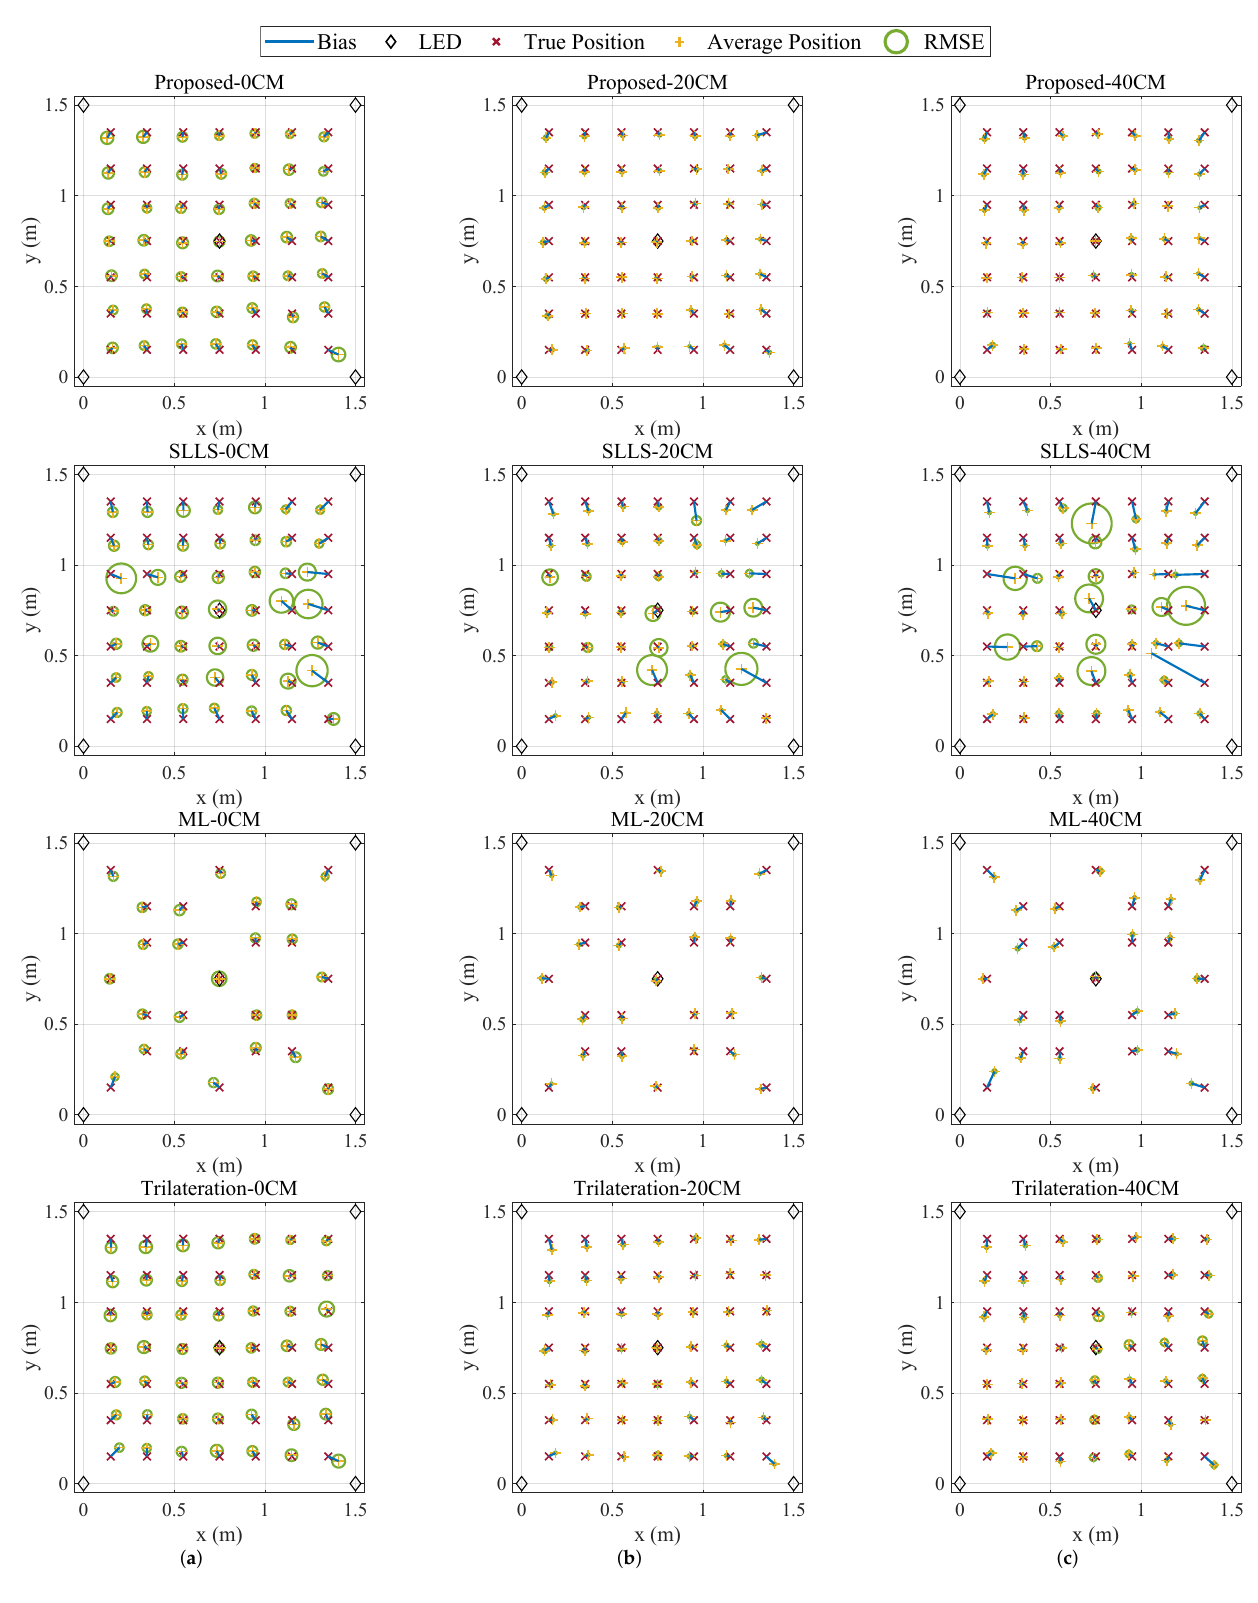
Figure 6. The 2D positioning distribution at different heights: ( a ) 0 cm, ( b ) 20 cm, ( c ) 40